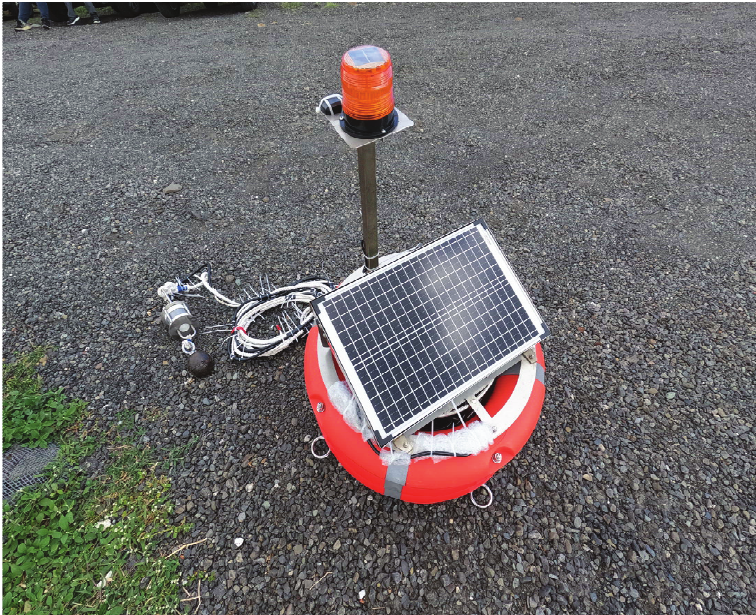
Figure 2. Proposed offshore buoy: main body and flow sensor